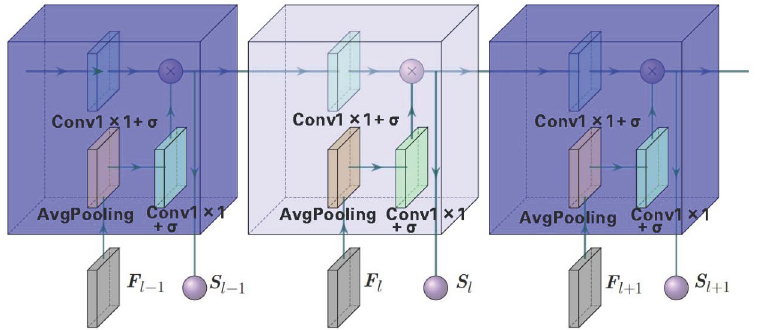
Fig 5. Information transmission flows in FGDC